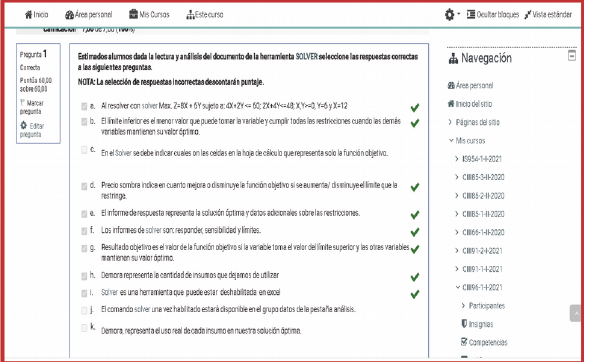
Figure 11. Solver evaluation in Moodle